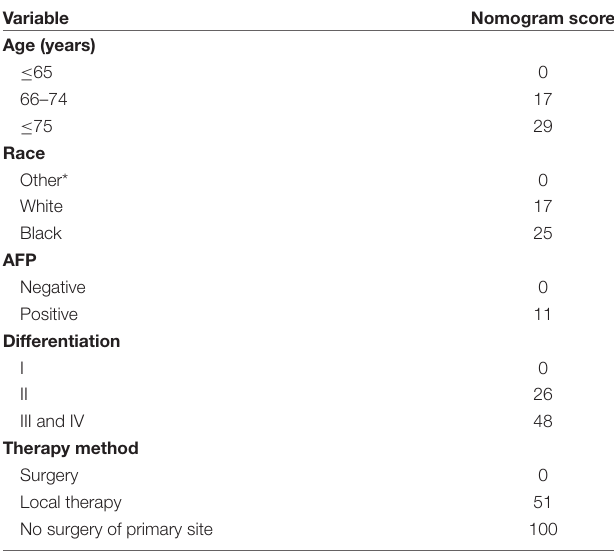
TABLE 3 | Detailed scores of all variables in the nomogram.